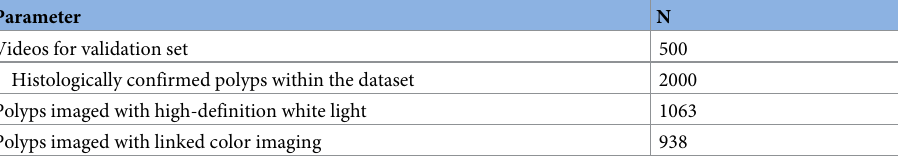
Table 1. Clinicopathological features of the training